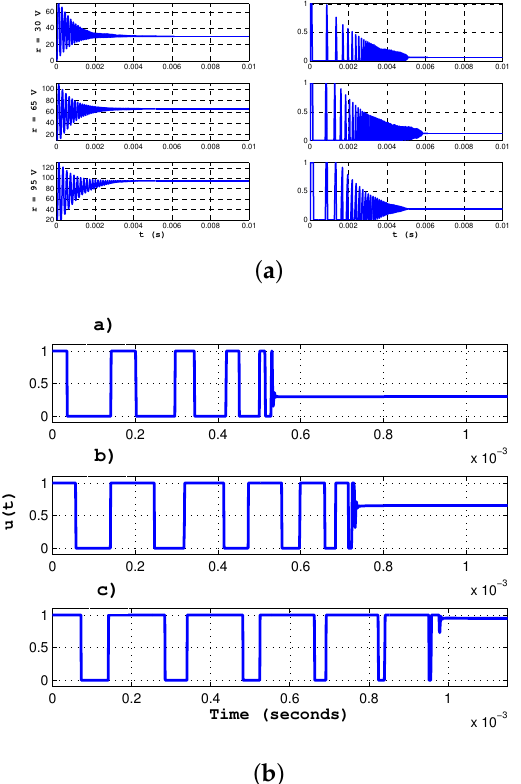
Figure 8. ( a ) Output voltage and inductor current of the Buck converter of Figure 1 controlled through the fractional-order PID (14). ( b ) Control laws produced by (14) for reference signal r a ) r = 30 V , b ) r = 65 V and c ) r = 95 V